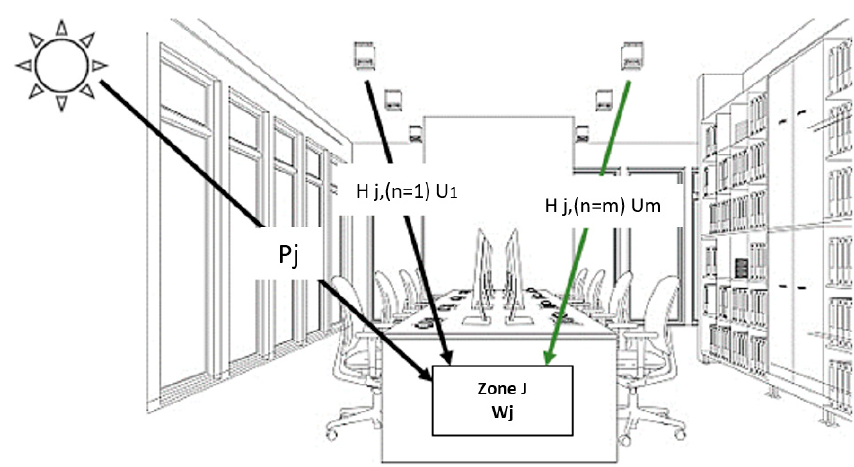
Figure 3. Lighting device impact on total illuminance level. Wj: total illuminance level; Pj: the average value of illumination contributed to the j -th zone due to outdoor daylight at time t; Hj,n: the average value of illumination of the j -th zone when the n -th device is at its maximum and all others are off.